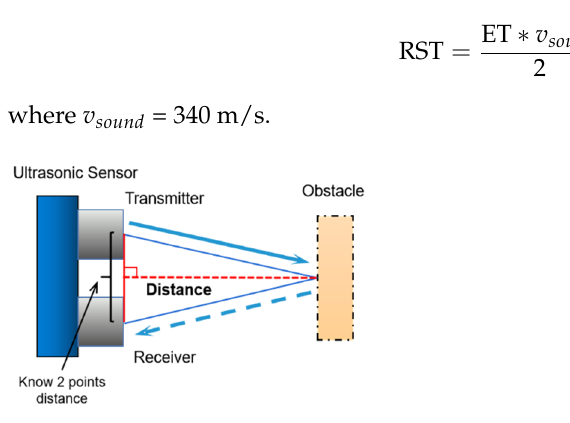
Figure 5. Ranging schematic diagram of the ultrasonic module.